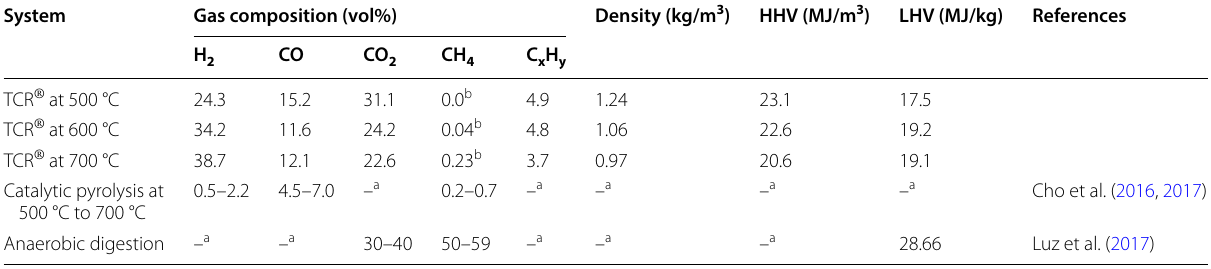
a Data are not available b The high content of hydrocarbons in the gases influences the detection of the other gases, especially methane caused by a crosswise relation between these compounds